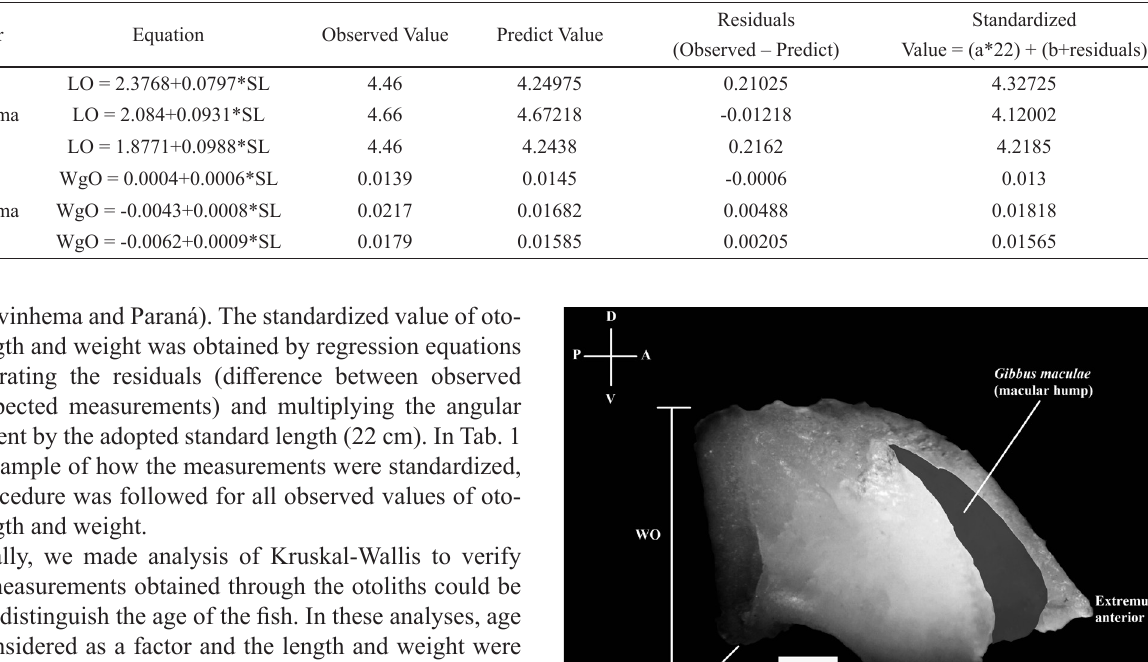
Tab. 1. Equations used and example of how the standardization of the length and weight of the otolith was carried out by removing the effect of the standard length of Prochilodus lineatus . This procedure was done for all observed values. a = an- gular coefficient; b = intercept.